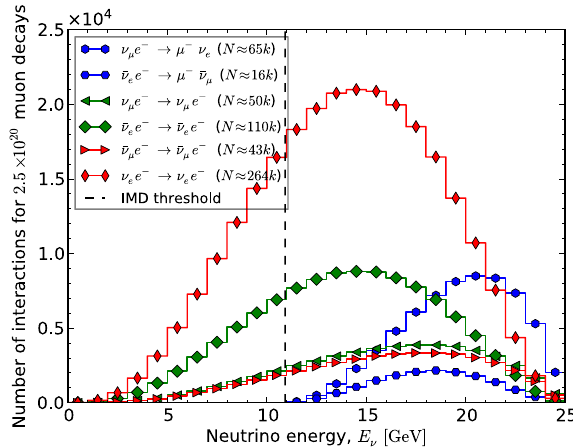
FIG. 4. Number of neutrino-electron interactions for a nominal year of neutrino factory operation ( 2 : 5 (cid:3) 10 20 muon decays per muon charge per straight section). Rates are calculated for a 2.7 t detector with 1 : 5 (cid:3) 1 : 5 m 2 frontal cross section and average Z=A (cid:4) 0 : 54 . The detector is placed 100 m after the straight section of the neutrino factory with 25 GeV muon energy. The dashed vertical line indicates the threshold for quasielastic